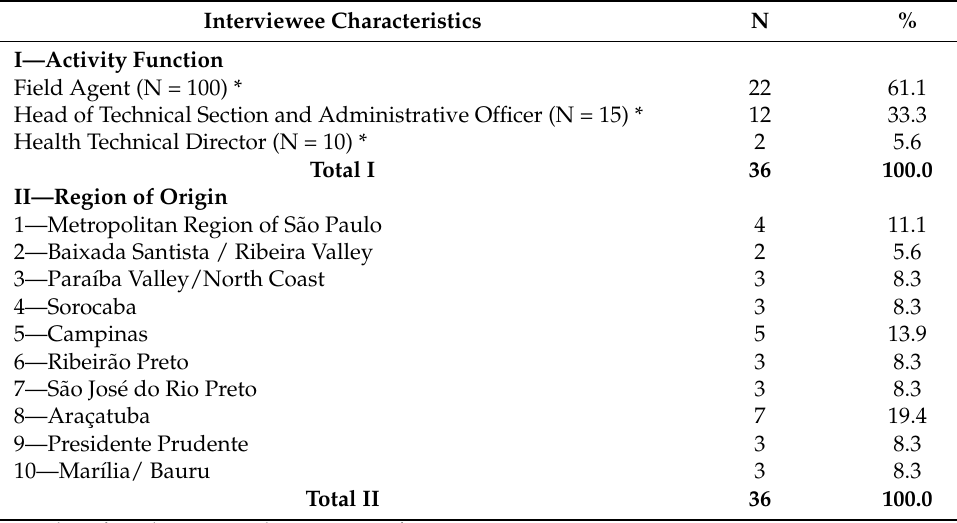
Table 1. Characterization of the participants for the evaluation of the implementation of SisaMob in the Superintendence of Endemic Disease Control (current Pasteur Institute), 2019.